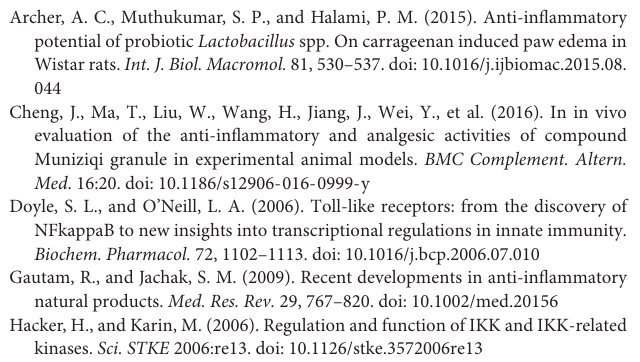
FIGURE S1 | Dose-response results for the effects of THC and OHC on the xyleneinduced ear edema in mice (A) and acetic acid-induced vascular permeability in mice (B) in our prior trial. Data are expressed as means ± S.E.M. ( n = 10), ∗ p < 0.05, ∗∗ p < 0.01, ∗∗∗ p < 0.001vs the vehicle control. Significant differences between groups were determined by ANOVA and Dunnett’s post hoc